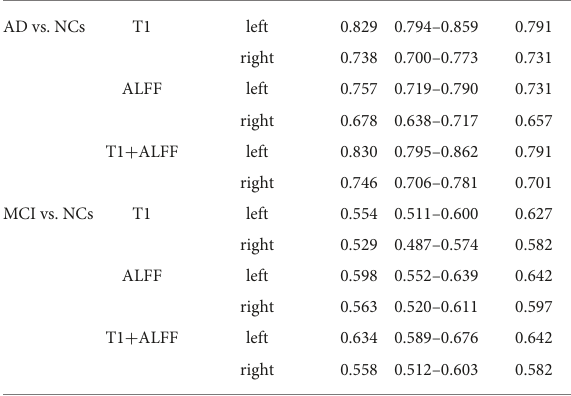
TABLE 4 External